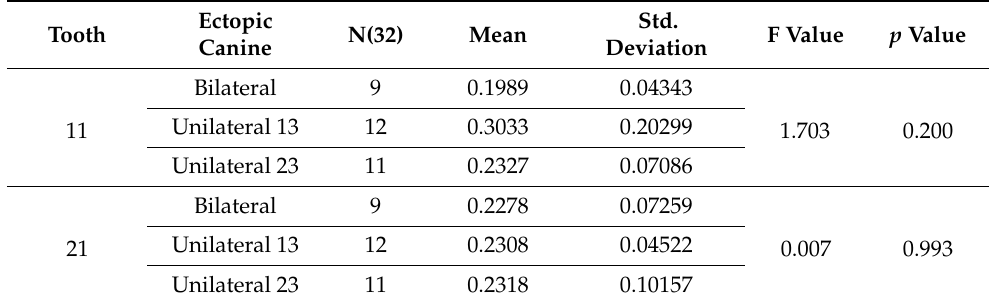
Table 4. ANOVA test results of mean root resorption (R) for the measured tooth (#11, #21, #12,